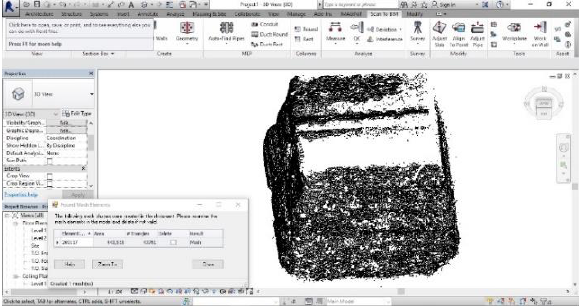
Figure 3. Create mesh from point clouds (Revit add-on: “Scan to BIM”)